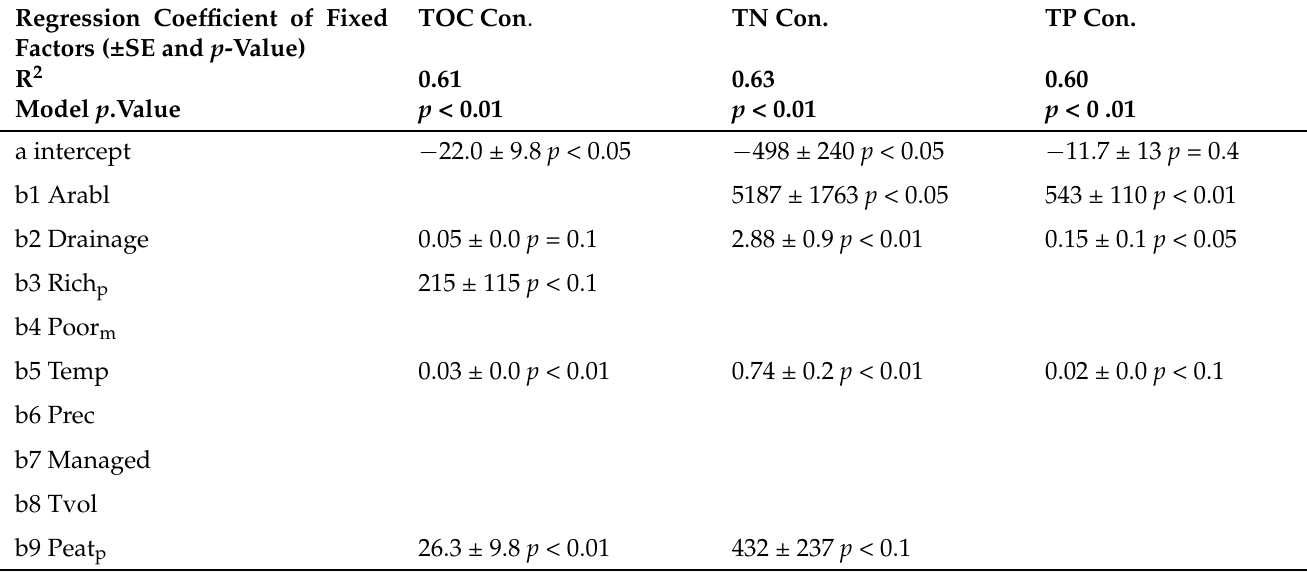
Table 1. Parameter estimates of fixed factors of the final models for concentrations.